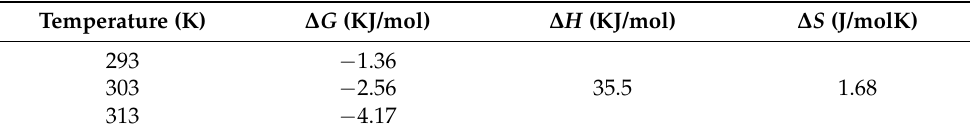
Figure 5. ( a ) Langmuir isotherm model and Freundlich isotherm model, ( b ) The intra-particle diffusion model, ( c ) Pseudo- second-order model, ( d ) Pseudo-first-order model. Table 3. Thermodynamic Parameters of Cr(VI) Adsorption on PEG@PTHA